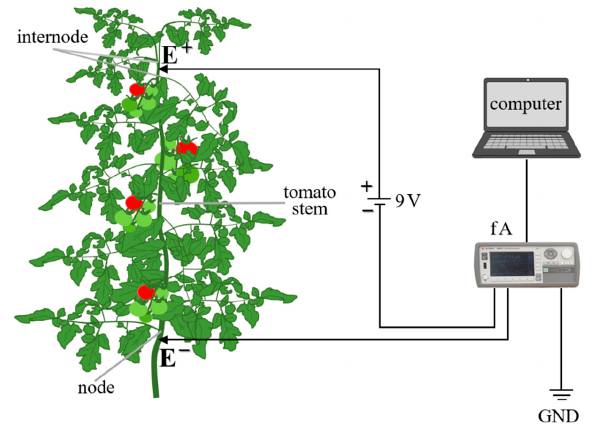
Figure 1. The electrical design used for monitoring and recording the electrical signal generated by the electrical charge flow through xylem sap of tomato. The electrical circuit included 9 V DC source, femto/picoammeter (fA), monitoring and controlling system (computer), standard grounding socket of the power supply system (GND) and two stainless steel electrodes: negative electrode (E − ) and positive electrode (E + ).